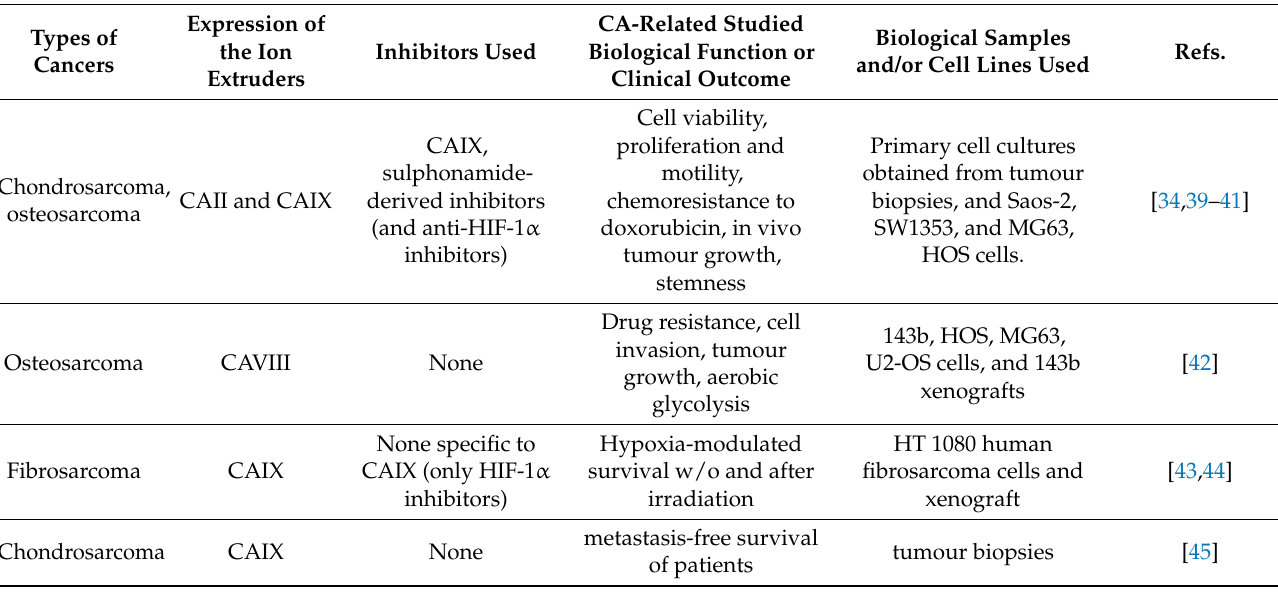
Table 2. CA expression and targeting in bone sarcomas.